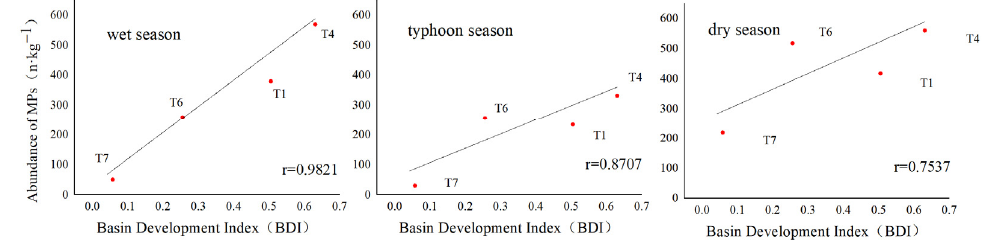
Figure 8. Correlation analysis between microplastic abundance and BDI.